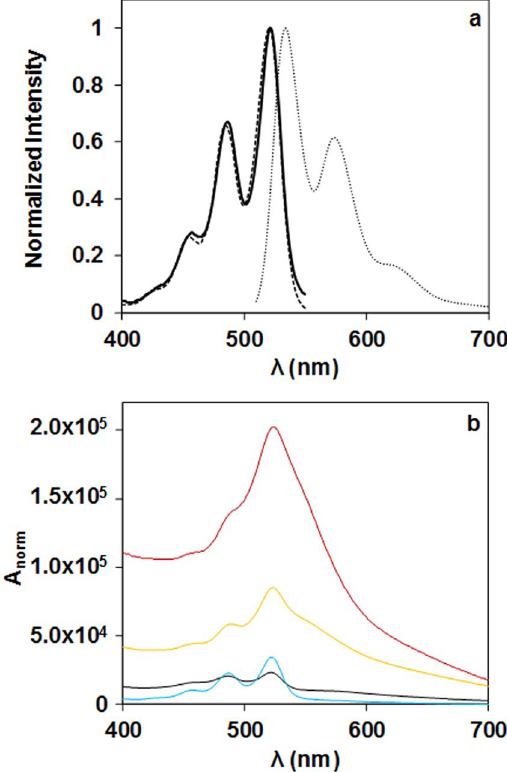
Figure 3. ( a ) Absorption (solid curve), excitation ( λ em = 580 nm, dashed curve) and emission ( λ ex = 480 nm, dotted curve) spectra of the PDI dye in ethanol; ( b ) Absorption spectra of SiNP-PDI (black curve), GNPSi13- PDI (blue curve), GNPSi9-PDI (yellow curve) and GNPSi7-PDI (red curve), normalized for equal PDI